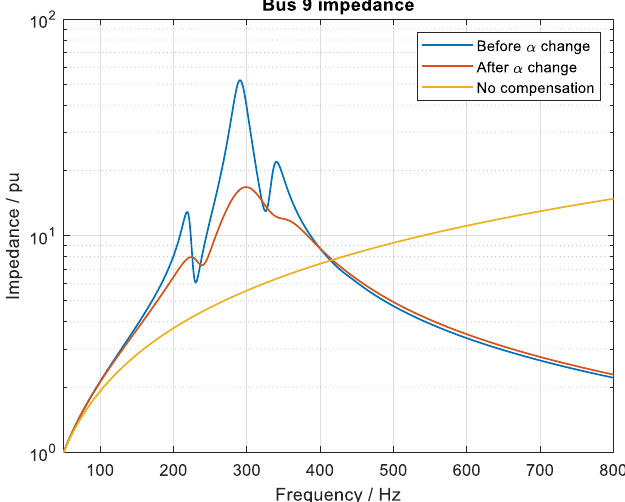
Figure 16. The 7th harmonic frequency parallel resonance mitigation in bus 9.